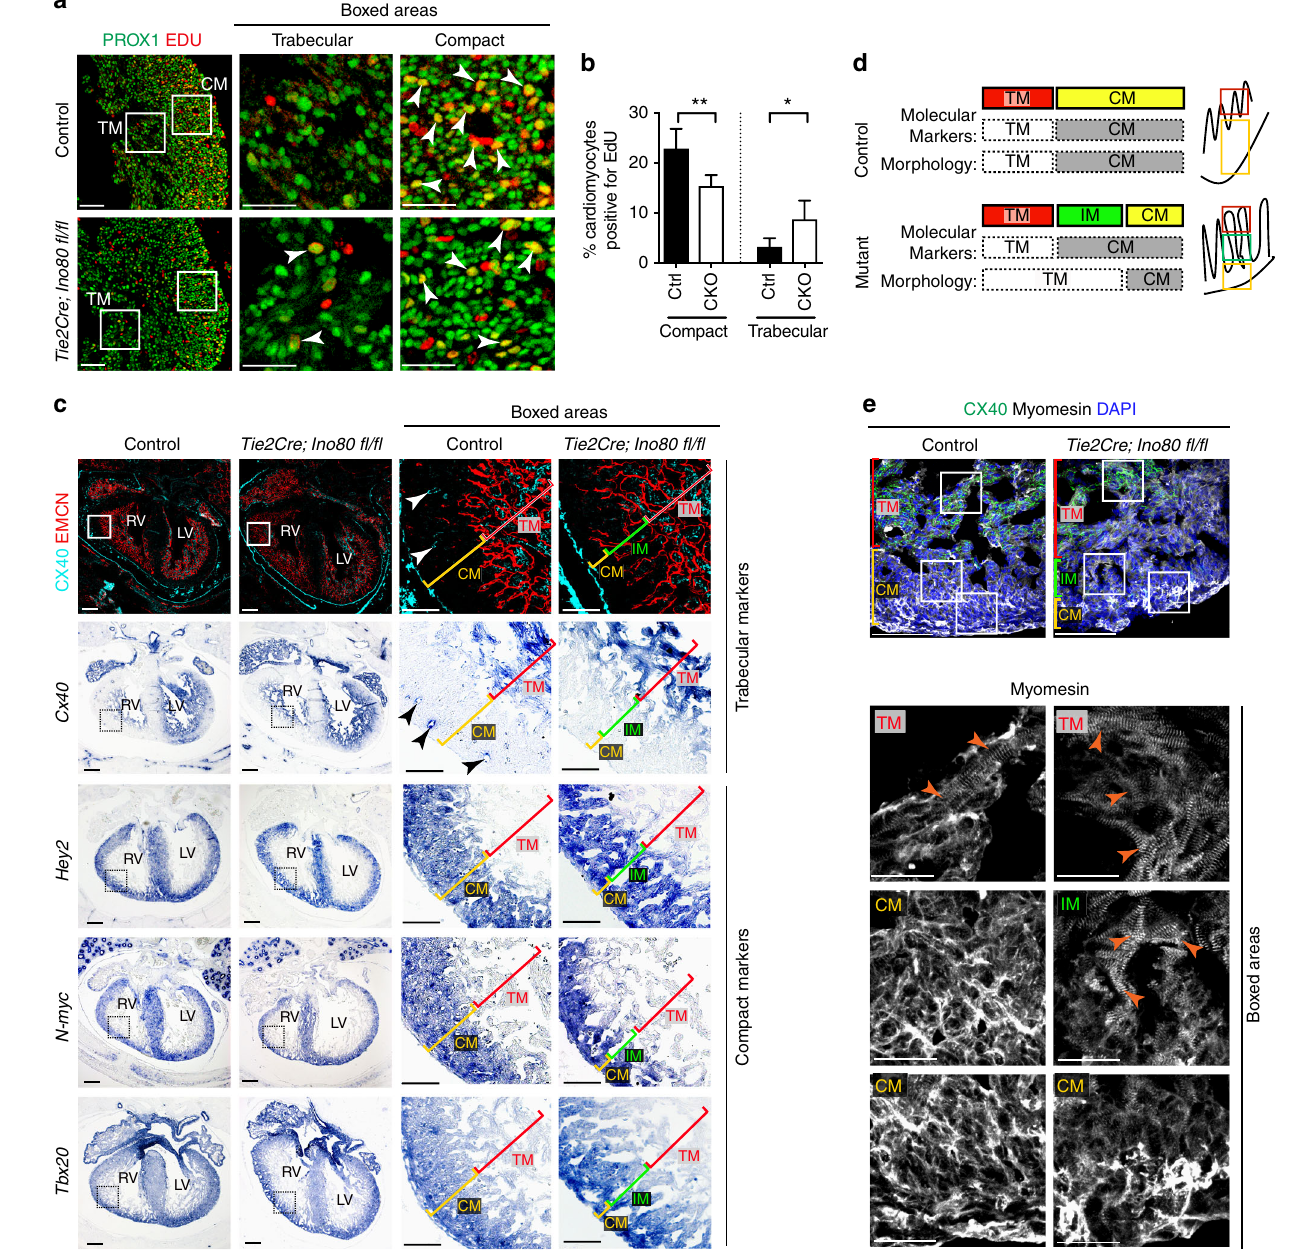
Fig. 2 Ino80 deletion in endocardial/endothelial cells results in ventricular non-compaction. a Tissue sections through e15.5 control and Tie2Cre;Ino80 fl / fl hearts treated with EdU and Immunostained for EdU and PROX1 to reveal proliferating cardiomyocytes (arrowheads). Images are representative of the following number of replicates: control, n = 7 hearts; mutant, n = 5 hearts at e15.5. Scale bars: 100 μ m (low) and 50 μ m (high magni fi cation). b Quanti fi cation showed that compact myocardium proliferation is reduced while trabecular proliferation is increased. Error bars in graphs are standard deviation. (control, n = 7 hearts; mutant, n = 5 hearts at e15.5). * P < 0.05; ** P < 0.01, evaluated by Student ’ s t -test. c Immuno fl uorescence and in situ hybridization on adjacent sections for trabecular (Cx40) and compact (Hey2, N-myc, and Tbox20) myocardium markers. Top row includes Endomucin (EMCN) immuno fl uorescence to demonstrate that mutants contain endocardial-lined trabeculae in regions where control hearts are compacted. Abnormal trabeculae adjacent to the thinned compact layer lack trabecular markers and express compact markers, a pattern that has been termed intermediate myocardium (IM). Images are representative of the following number of replicates: control, n = 3 hearts; mutant, n = 3 hearts at e15.5. Arrowheads indicate Cx40 + coronary arteries present in control hearts. Scale bars: 100 μ m (low) and 25 μ m (high magni fi cation). d Schematic of marker expression and morphology in control and mutant hearts. Intermediate myocardium is a region exhibiting a mismatch in morphology and markers, and is only extensive in non-compacted hearts e Myomesin immuno fl uorescence reveals that intermediate myocardium also contains trabecular-like sarcomere morphology (arrowheads). Images are representative of the following number of replicates: control, n = 3 hearts; mutant, n = 3 hearts at e15.5. CM compact myocardium, TM trabecular myocardium. Scale bars: 100 μ m (low) and 25 μ m (high magni fi